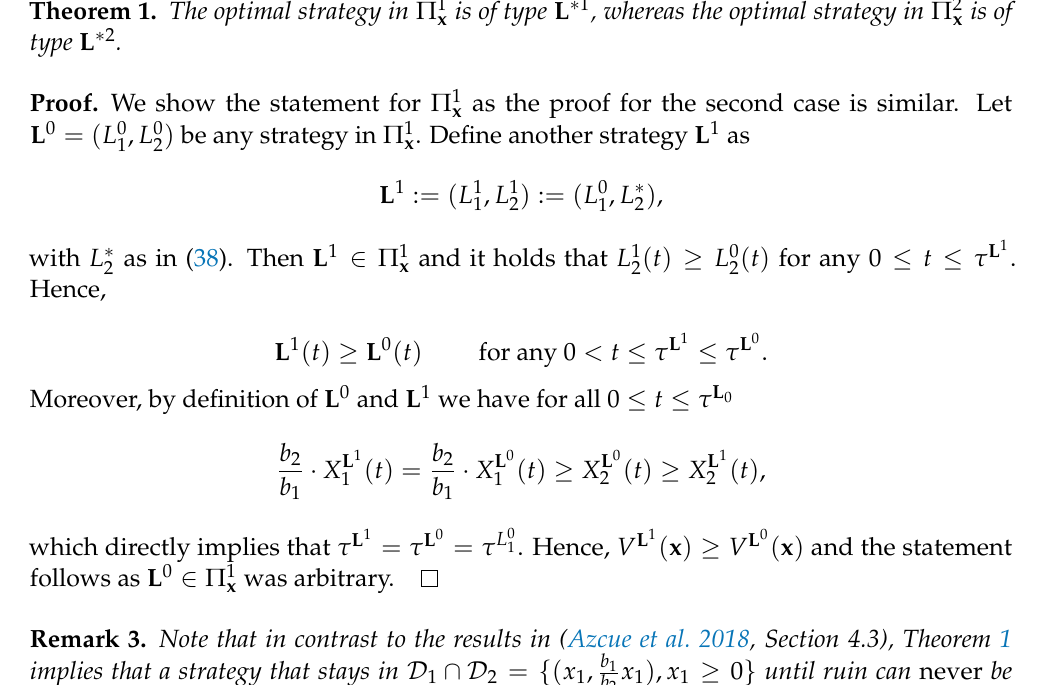
, and a sample path of X D 1 D 2